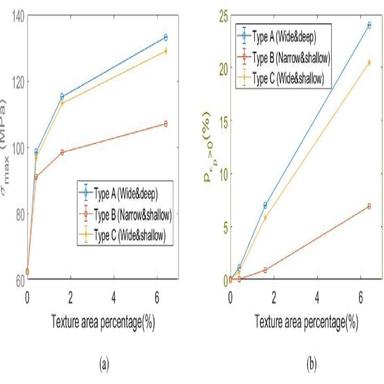
(a) Maximum contact stress and (b) percentage of surface elements under plastic deformation on the composite surface sliding against steel surface textured with different types of dimples in different coverages at steady state.